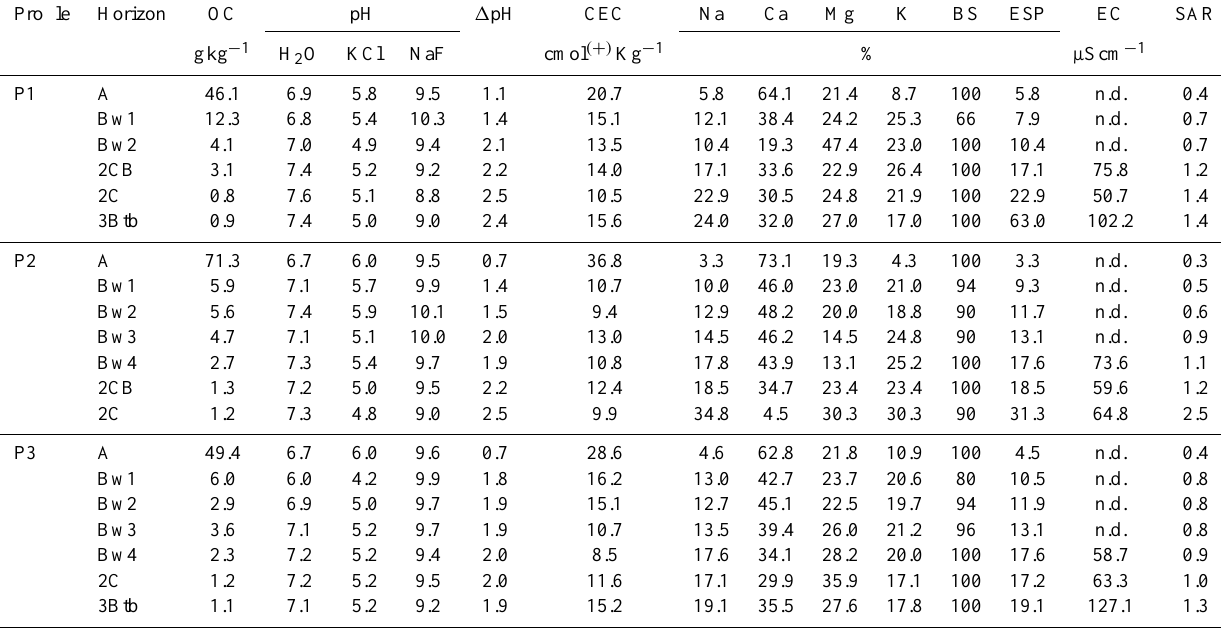
Table 2. Soil chemical properties.